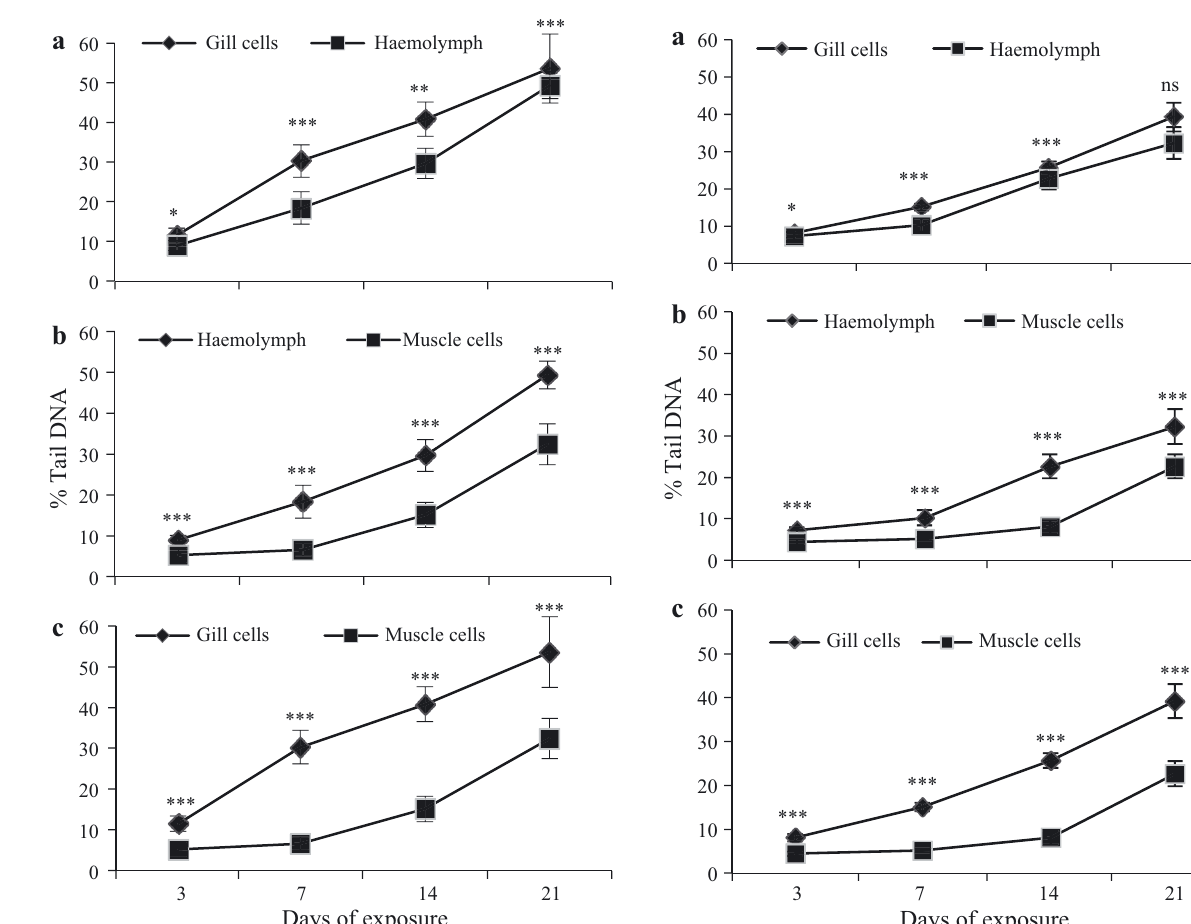
Fig. 3. Comparison of % DNA damage induced by sublethal concentration SL1 (0.36 µg l –1 ) of chlorpyrifos in gill, haemolymph, and muscle cells of Litopenaeus vannamei juveniles at the end of 3, 7, 14 and 21 days of exposure. (a) Gill vs. haemolymph, (b) haemolymph vs. muscle, (c) gill vs. muscle. Data are mean ± SD. *p < 0.05, **p < 0.01,